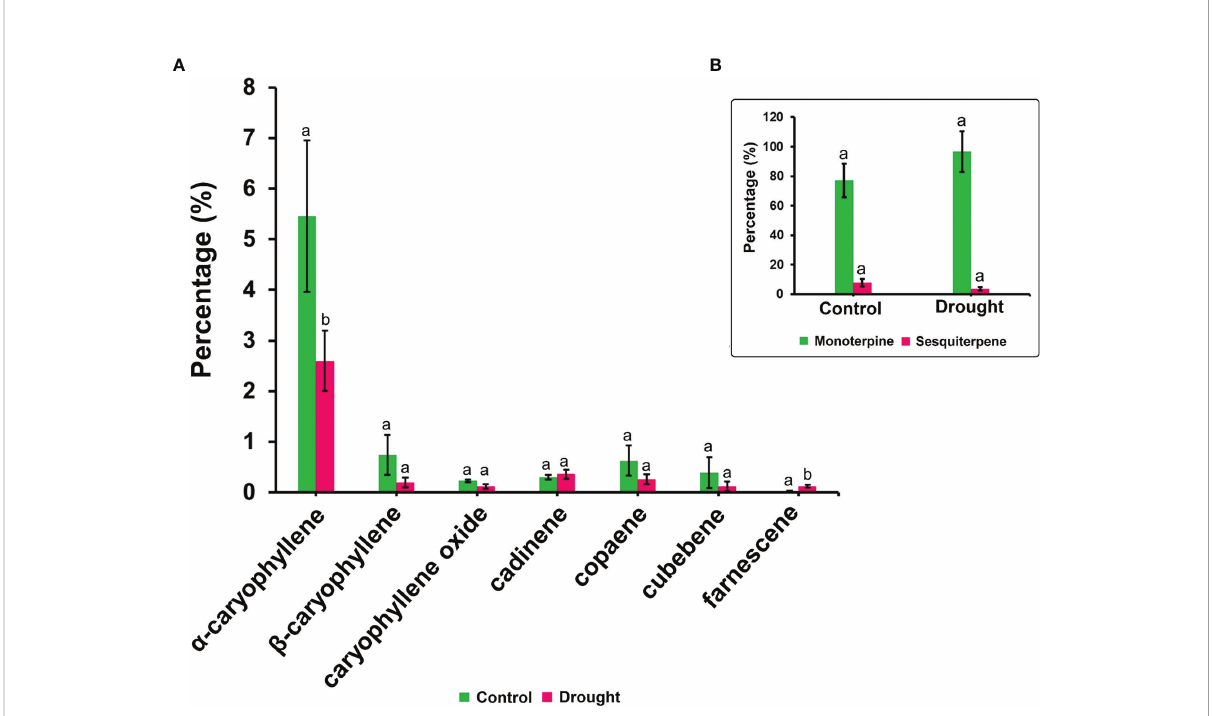
FIGURE 5 Volatile synthesis (VOC)-Sesquiterpenes. (A) list of sesquiterpenes and their content in root samples (B) total accumulation of main monoterpenes and sesquiterpenes in root samples measured 32 DAT. Results highlight the in fl uence of severe drought on the decline in total sesquiterpene accumulation supported by a decrease in major sesquiterpenes like a -caryophyllene, b -caryophyllene and cadinene. Farnescene being the only sesquiterpene showing a non-signi fi cant increase in their content among drought treated seedling sample. Means denoted with different letters indicate signi fi cance at